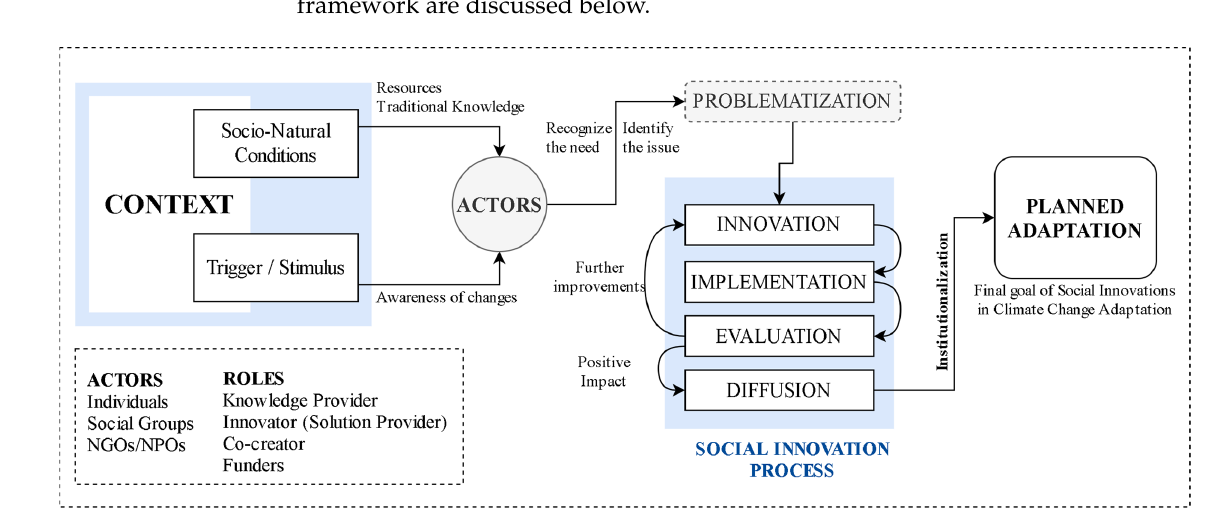
Figure 1. Framework for Social Innovation in Climate Change Adaptation.